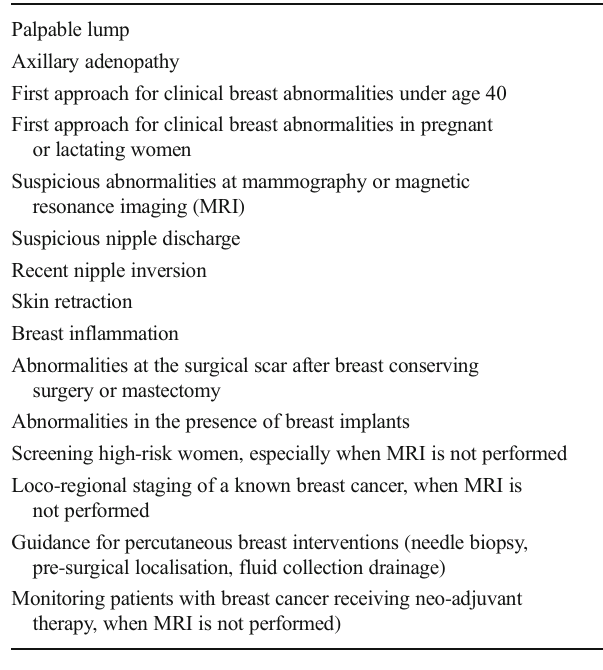
Definite indications for breast